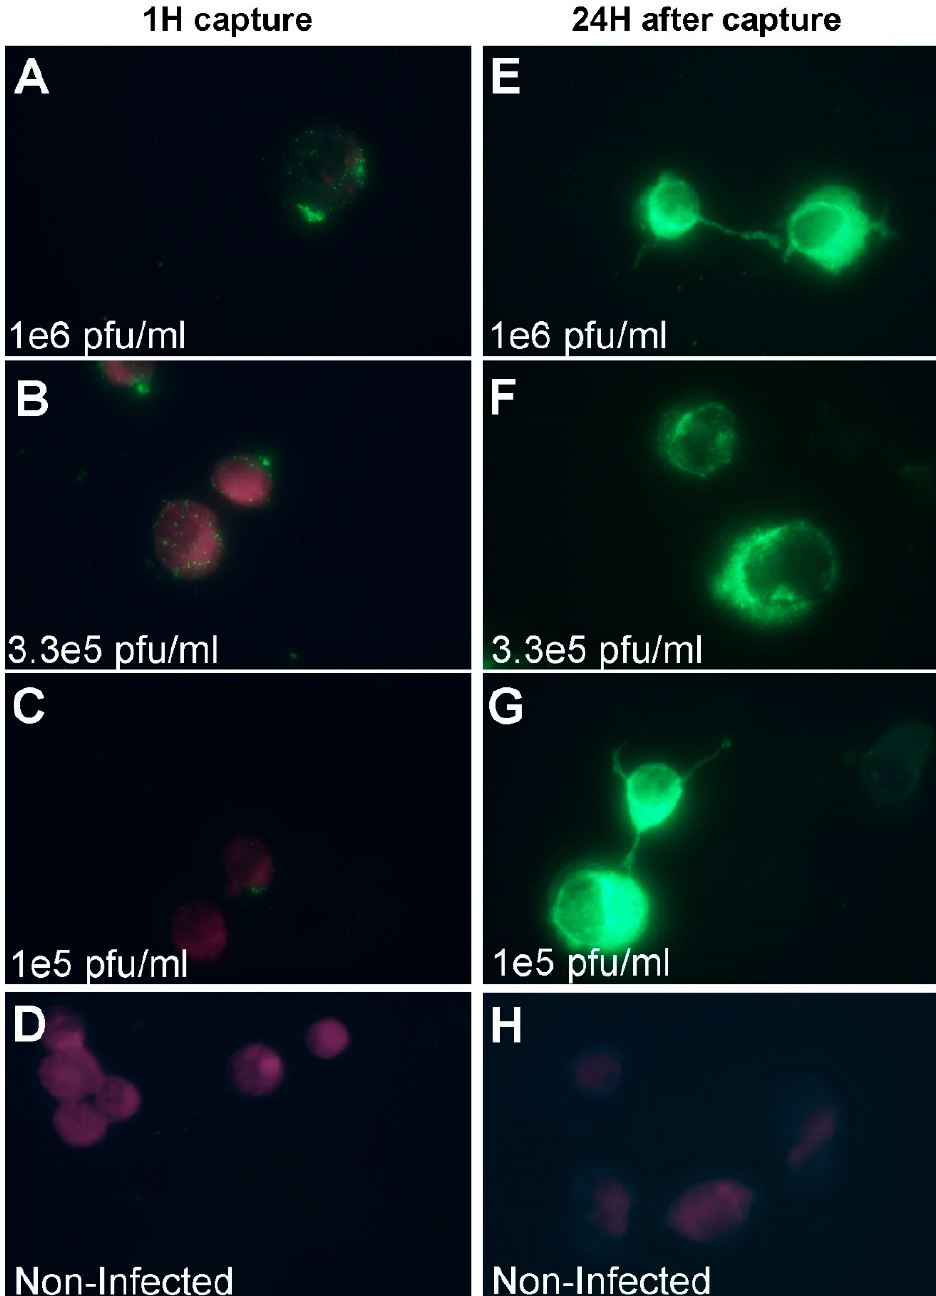
Figure 5. Fluorescence microscopy imaging of MVA after capture with Vero cells. ( A – D ) Suspended Vero cells were mixed with MVA at the indicated concentrations for one hour with shaking to allow attachment. After capture, the cells were pelleted and processed directly to IFA. The cells are labeled with purple color and viruses are in green. ( A , B ) Numerous viral particles could be observed on the cells surface after an hour of incubation with the cells. ( C ) Few MVA particles were seen on the cells surface. ( D ) No virus bound cells were observed in the control cells. ( E – G ) Suspended Vero cells were mixed with MVA at the indicated concentrations for one hour with shaking at 4 °C to allow attachment and then seeded in Labtek dishes for additional 24 h to allow virus replication. The cells were then processed to IFA. Intensive cellular staining was noted at all virus doses. ( H ) No cellular staining was observed in non-infected cells after 24 h of incubation.